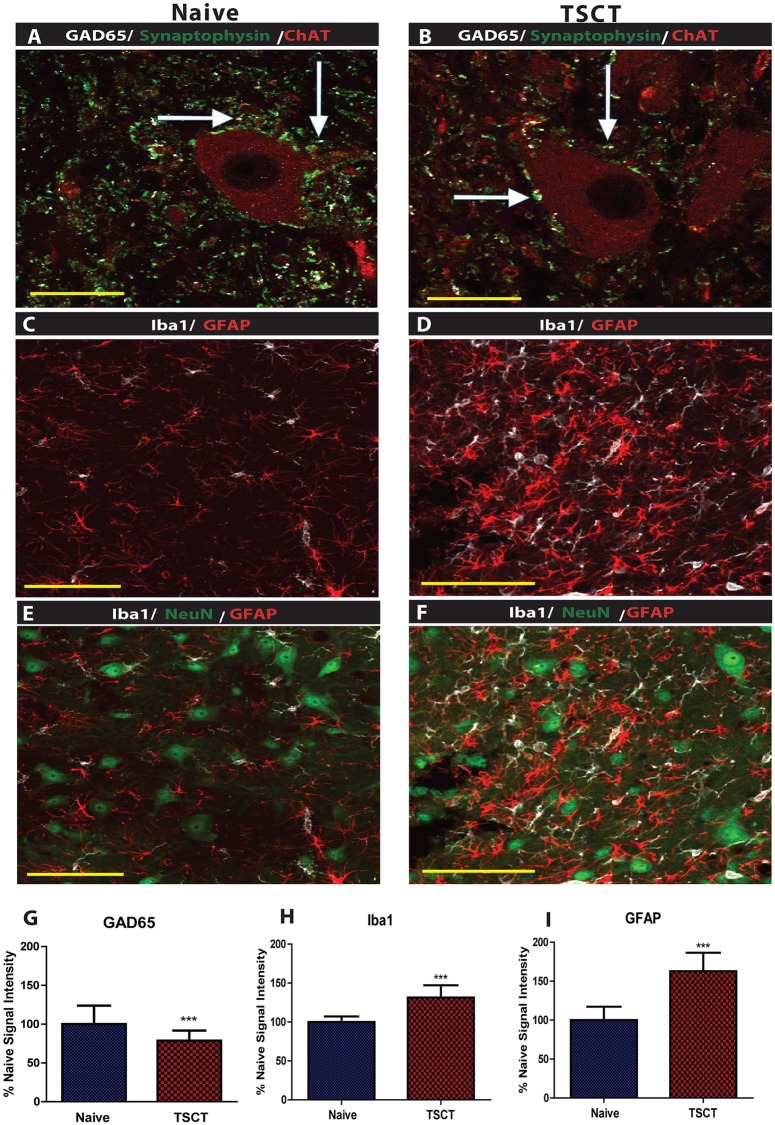
Immunofluorescence analysis of lumbar spinal cord sections at 3 months after spinal cord transection.
(A, B)- Qualitative analysis of GAD65 and synaptophysin immuoreactivity showed normally appearing double-labeled synaptophysin/GAD65+ puncta (white arrows; confocal microscopy). (C, D, E, F)- Immunostaining with Iba1 and GFAP antibody (C, D) and NeuN (E, F) showed normally-appearing neurons, but an increase in IB1 and GFAP immunoreactivity in activated-hypertrophic astrocytes and microglial cells in lamina VII. (G, H, I)- Quantitative densitometric analysis of GAD65, GFAP and IB1 immunoreactivity showed a decrease in GAD65 and increase in GFAP and IB1 staining in TSCT animals if compared to naïve controls (t-test ***-p<0.001; scale bar: A, B: 50 μm C, D, E, F: 200 μm).